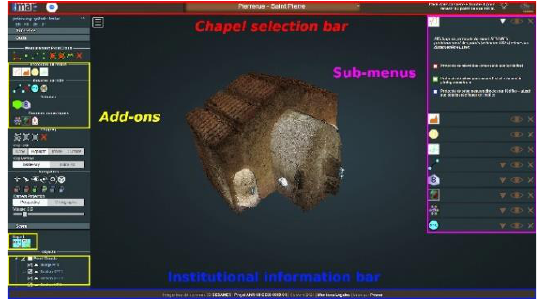
Figure 2 : Overview of the enhanced interface with selection menu, institutional information, tools and sub menus.